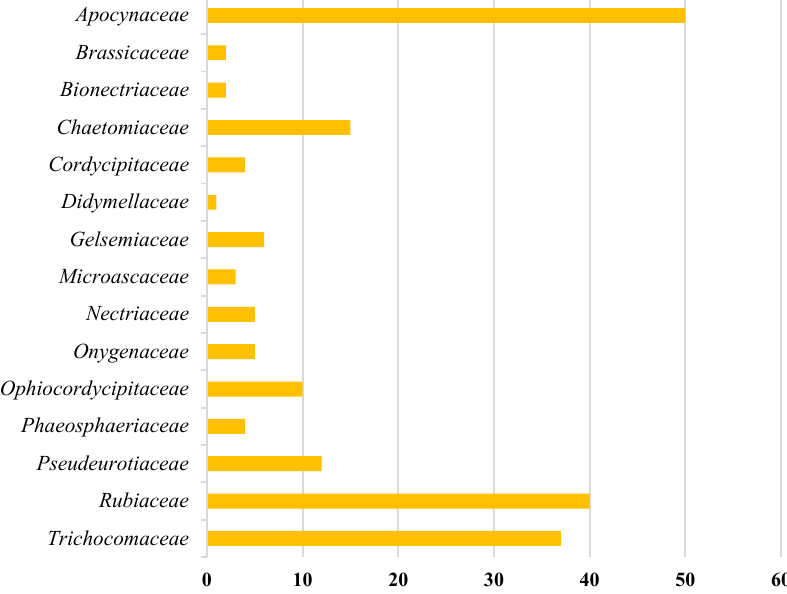
Figure 2. Distribution of indole alkaloids across plant, tree, and fungal sources.